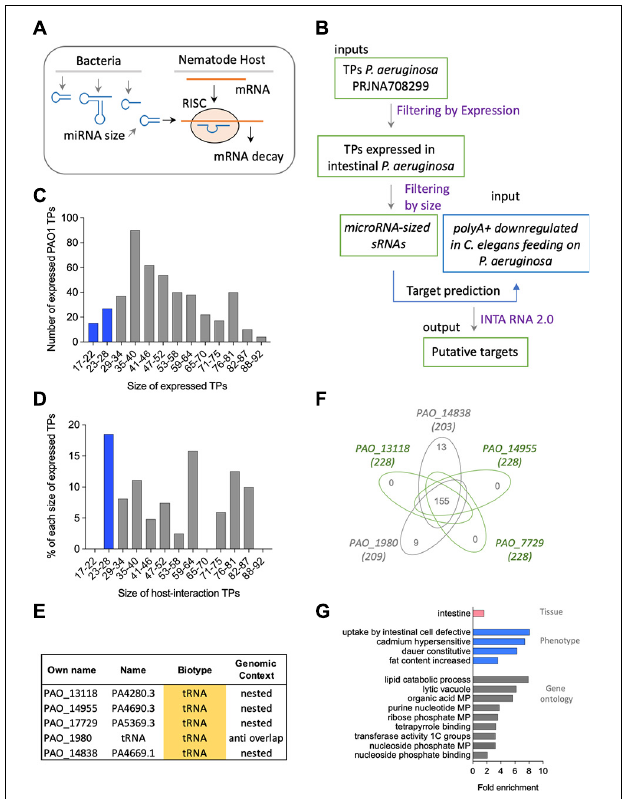
FIGURE 4 | (A) Representation of the putative mechanism of interaction based on miRNA-like mechanisms of bacterial sRNAs targeting host mRNA. (B) Methodological flow to address the mechanism proposed in panel (A) . (C) Size and number of expressed transcriptional peaks (TPs) in P. aeruginosa PAO1. (D) Size and number of induced RNA TPs in P. aeruginosa PAO1. (E) Biotype and genomic context of microRNA-sized -induced TPs in P. aeruginosa PAO1. (F) Venn diagram of mRNAs targeted by the five miRNA-like-induced sRNAs. (G) Tissue (pink), phenotype (blue), and gene ontology (gray) enrichment of mRNAs targeted by the five miRNA-like-induced